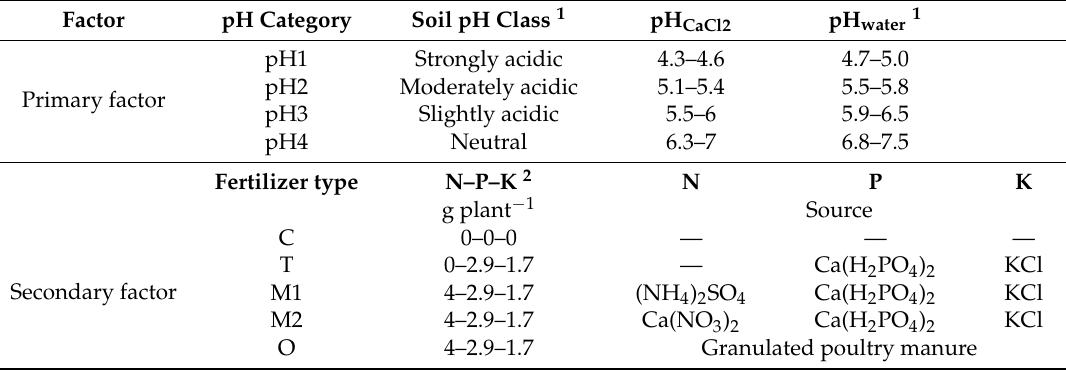
Table 2. Experimental factors used for this